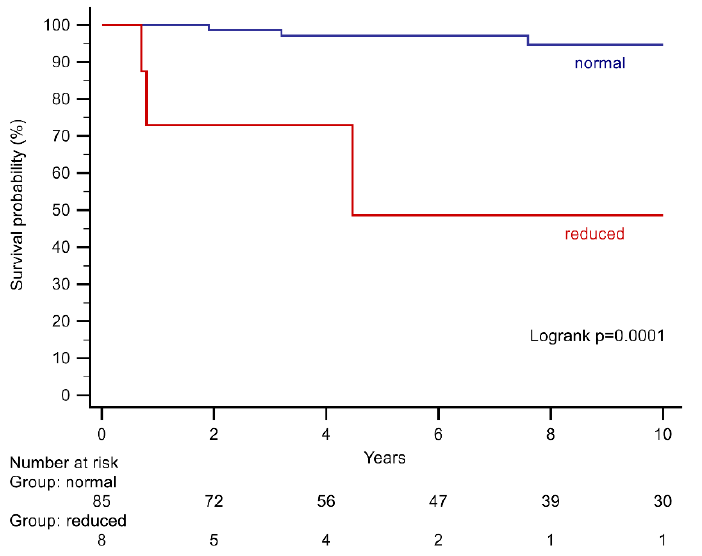
Figure 5. Kaplan–Meier curves stratifying patients according to systolic left ventricular function at baseline.